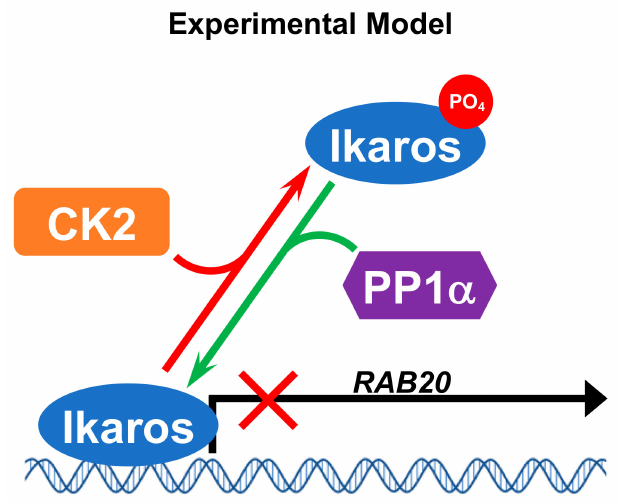
Figure 6. Model of proposed regulation of Rab20 expression by Ikaros, CK2, and PP1 α . Ikaros represses RAB20 transcription. PP1 α stimulates Ikaros activity resulting in decreased RAB20 transcription. CK2 inhibits Ikaros activity resulting in increased Rab20